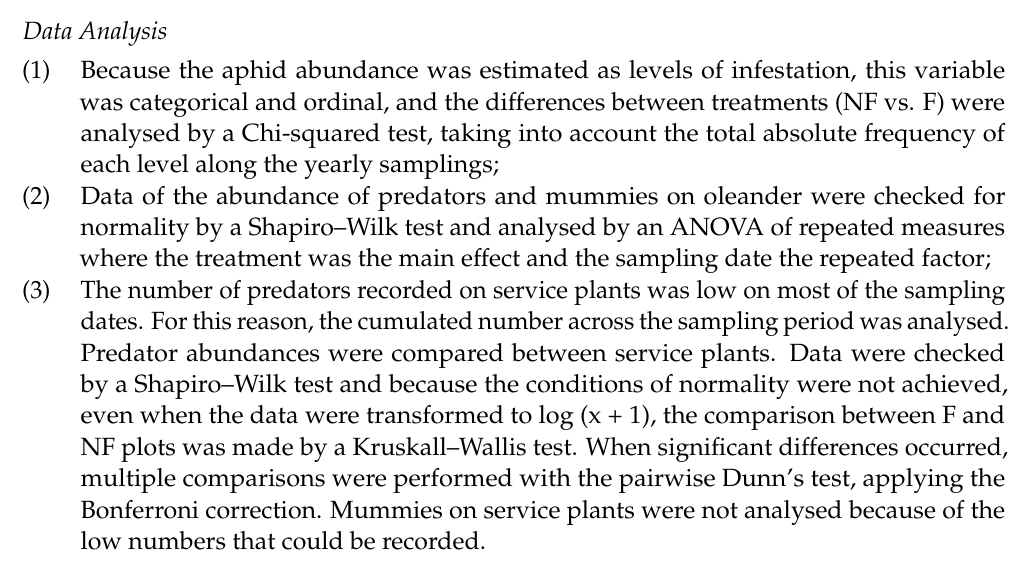
Table 1. Scale of infestation severity of aphids in oleanders [26,27]. Level Aphid Infestation 0 No aphids 1 Presence of isolated individuals 2 Small Colonies 3 Medium colonies 4 Large